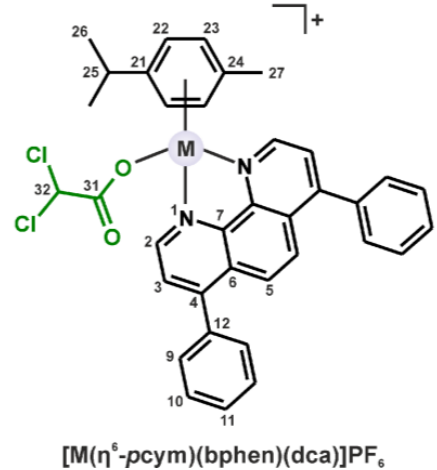
Figure 1. General structural formula of the [M(η 6 - p cym)(bphen)(dca)]PF 6 complexes, where dca = dichloroacetate M = Ru for Ru-dca and Os for Os-dca ), given with the atom numbering